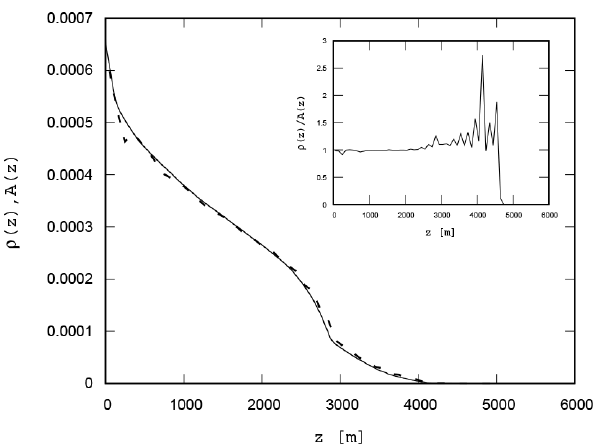
Figure 5. The continuous line is the area that the Mediterranean has at each depth z . The dashed line is microplastic density per unit of depth ρ(z) under continuous release of particles with β = 0 . 8 at 1m depth. Both curves have been normalized to have unit area, so that they can be compared on the same scale. The binning size is 100m. The inset shows the ratio ρ(z)/A(z) , proportional to the mass density of microplastic per unit of volume ρ V (z)